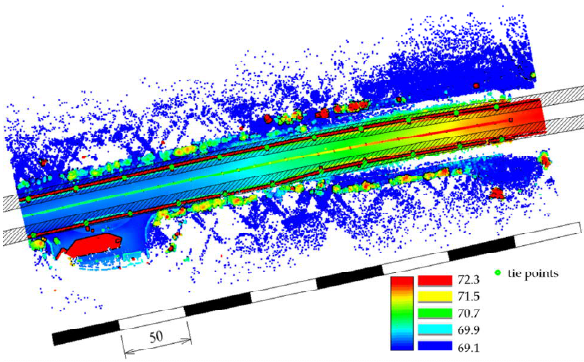
Figure 17 . The example of identified tie points on pole-like infrastructures along the